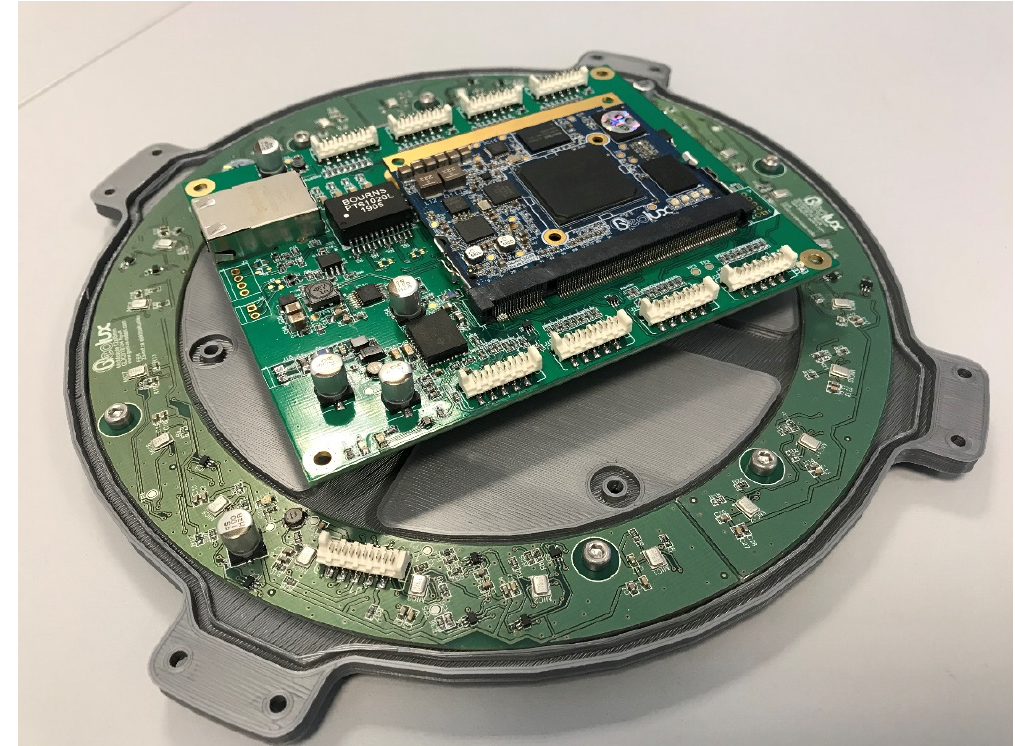
Figure 1. Acoustic camera motherboard module with mounted electronic components.